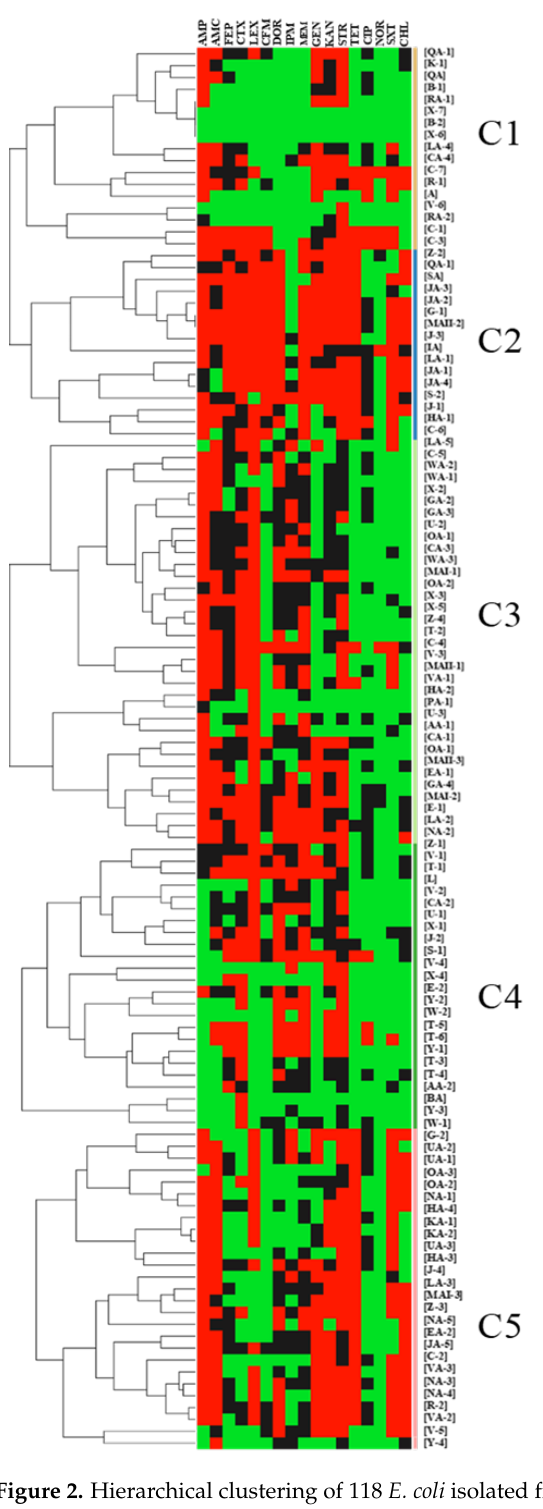
Figure 2. Hierarchical clustering of 118 E. coli isolated from Akkawi cheese in Lebanon. The isolate labels (IDs) refer to the associated cheese sample and the isolate number (if more than one E. coli was isolated from the same cheese sample). For example, [B-1] indicates that E. coli isolate #1 that was retrieved from Akkawi sample B. Squares in red represent resistance while those in black and green indicate intermediate resistance and susceptibility, respectively. The clusters are represented by the letter